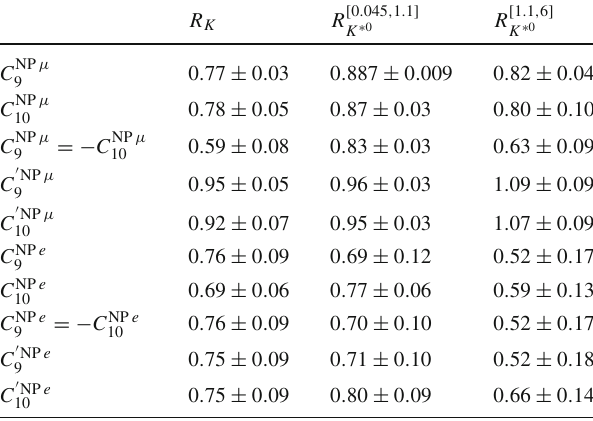
Table 2 R K , R K ∗ 0 predictions with 1 σ uncertainties corresponding to the best fit Wilson coefficients of Table